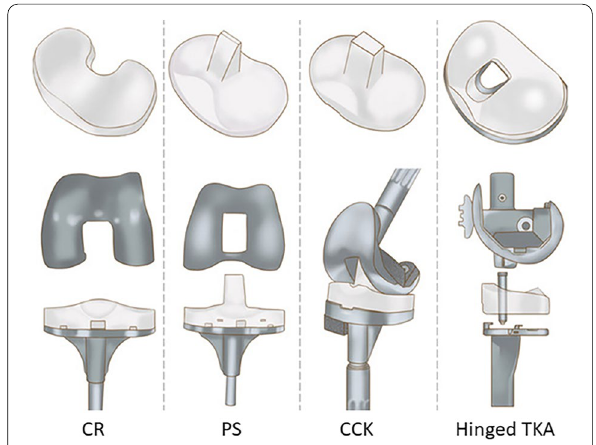
Fig. 1 Different levels of constraint in TKA prostheses, from the less to the most constrained (from left to